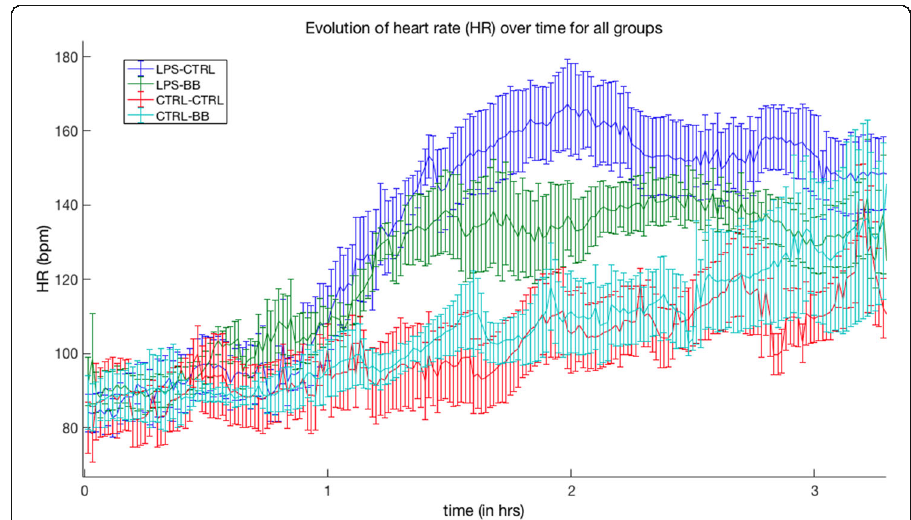
Fig. 4 Evolution of heart rate. Evolution of heart rate over the course of the experiment ( t = 0 to 3 h) for all experimental groups: LPS-CTRL (blue), LPS-BB (green), CTRL-CTRL (red), and CTRL-BB (cyan). Each point represents a 5-minute sample epoch from which the median and interquartile ranges are derived and indicated with error bars. Starting from 1 hour, the LPS-* groups start showing increased HR following endotoxin challenge. Shortly before 2 h, the LPS-BB shows a reduced HR compared to the LPS-CTRL group mediated by beta-blocking effect